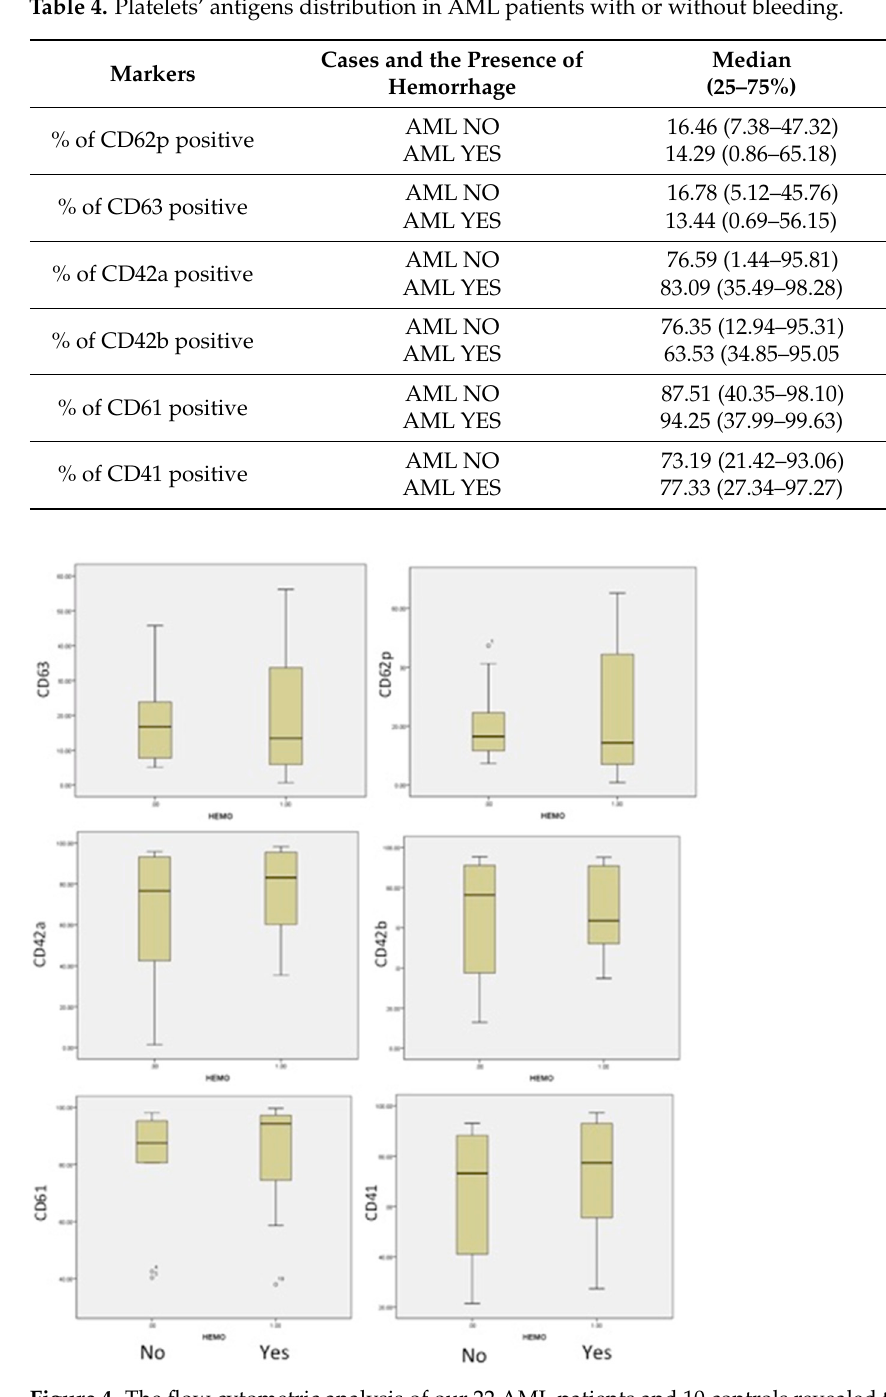
Figure 4. The flow cytometric analysis of our 22 AML patients and 10 controls revealed the following platelet characteristics. Patients without bleeding (arm No) or with bleedings (arm Yes) are represented in the boxplots with the level of expression for platelets markers CD61, CD41, CD42a, CD42b, CD62p and CD63.